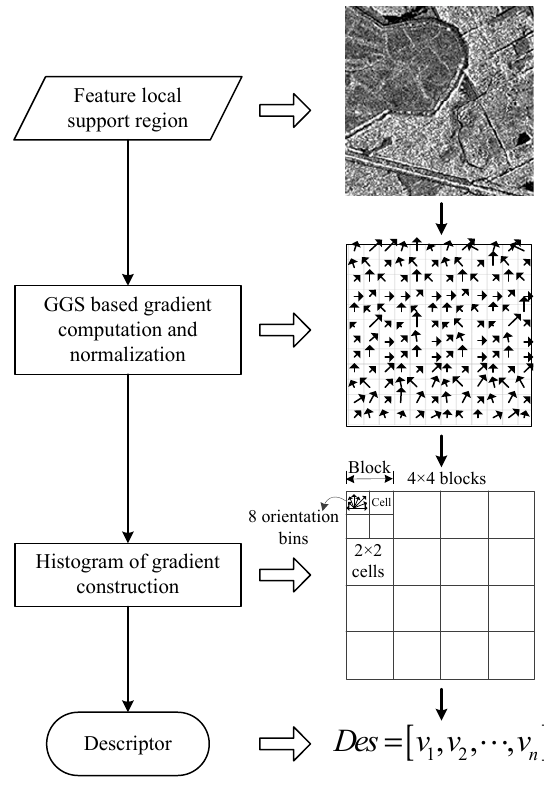
Figure 3. Flowchart of descriptor computation.